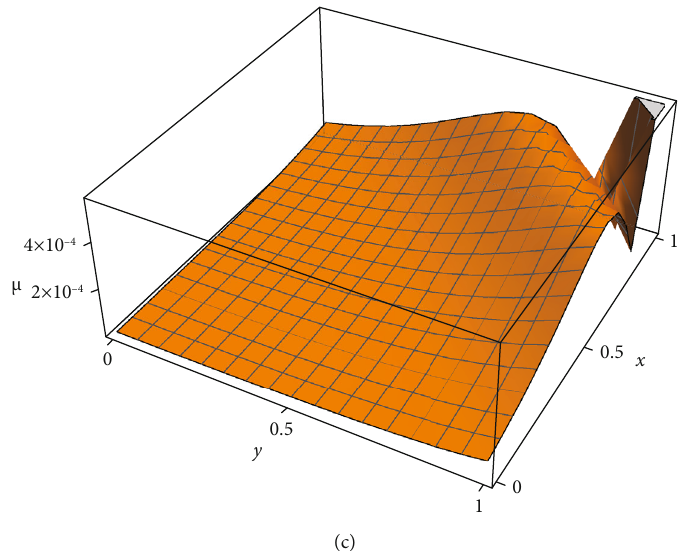
Figure 1: (a) Exact solution, (b) absolute error of NTDM